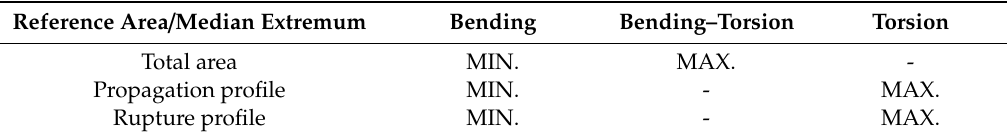
Table 6. Median extremum for individual reference